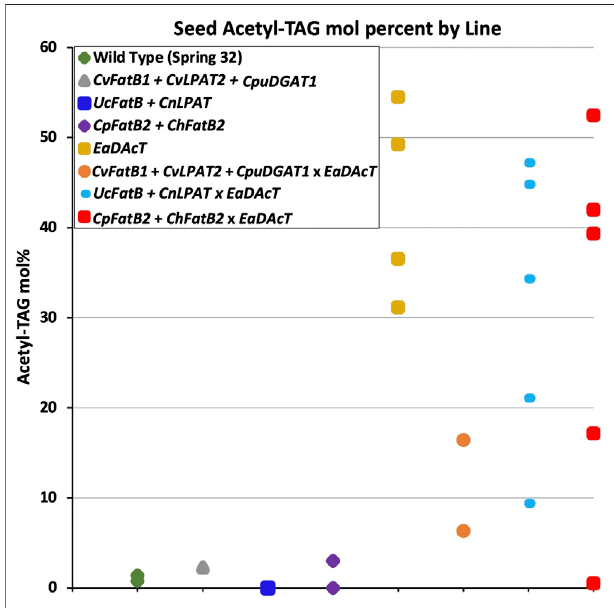
FIGURE 6 | Comparison of F 3 seed acetyl-TAG amounts in lines generated by crossing a pennycress transgenic EaDAcT line with transgenic lines harboring one of three MCFA biosynthetic genes combinations.